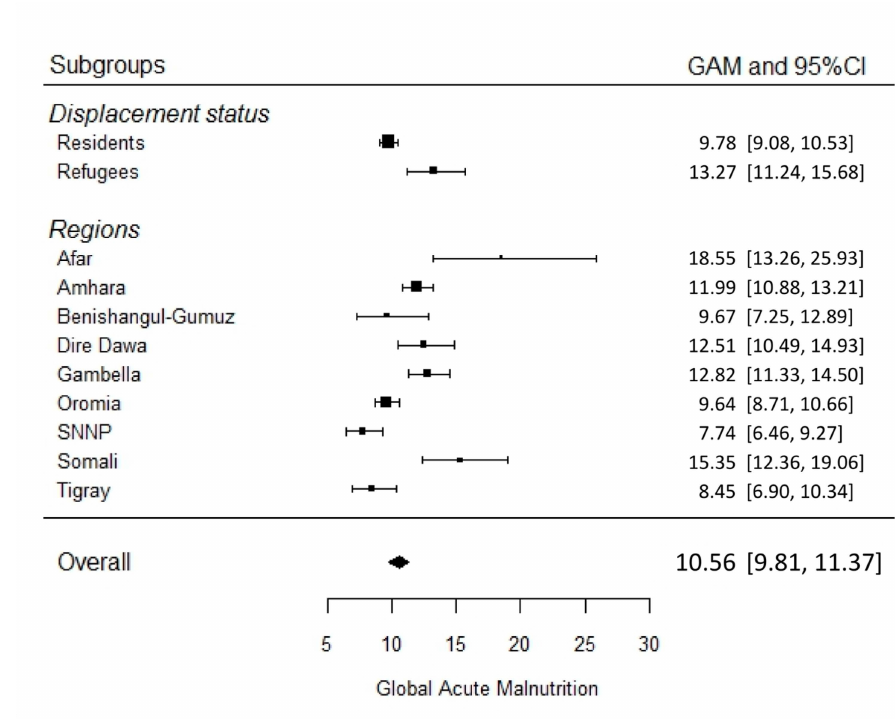
Figure 2. Forest plot of GAM summary estimates of surveys from Ethiopia emergency areas by region and population group, 2008–2013 (prevalence and 95% confidence